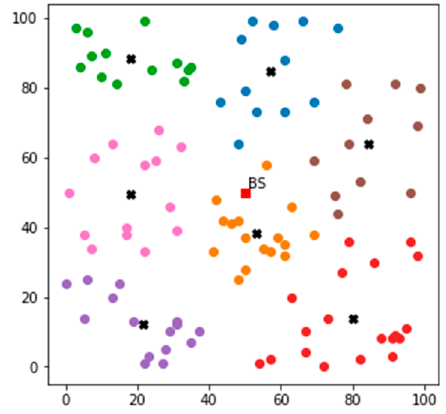
Figure 7. Network clustering using k-means algorithm.